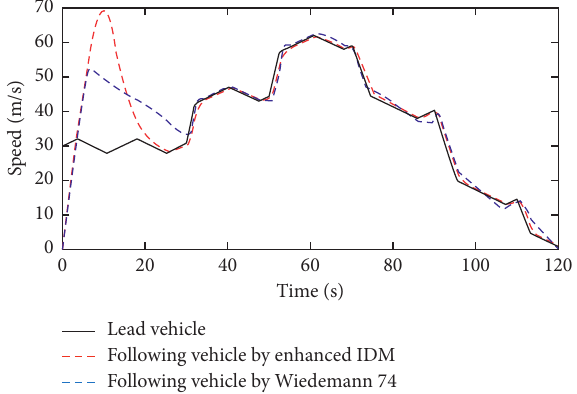
Figure 1: Comparison of car-following